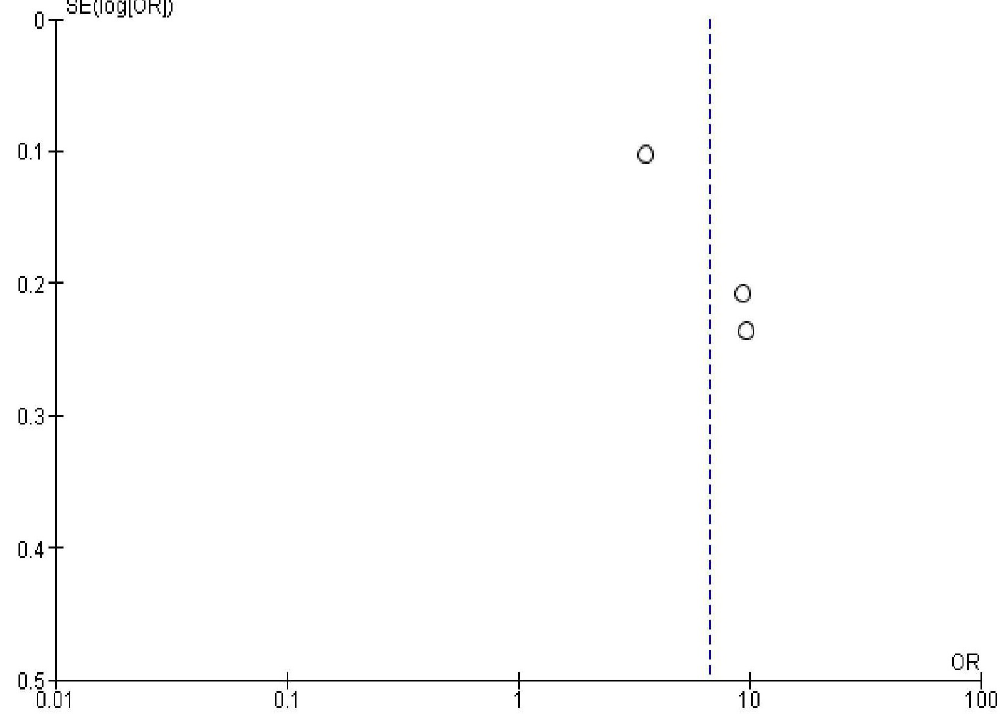
Fig 21. Publication bias on birth in the health facility.